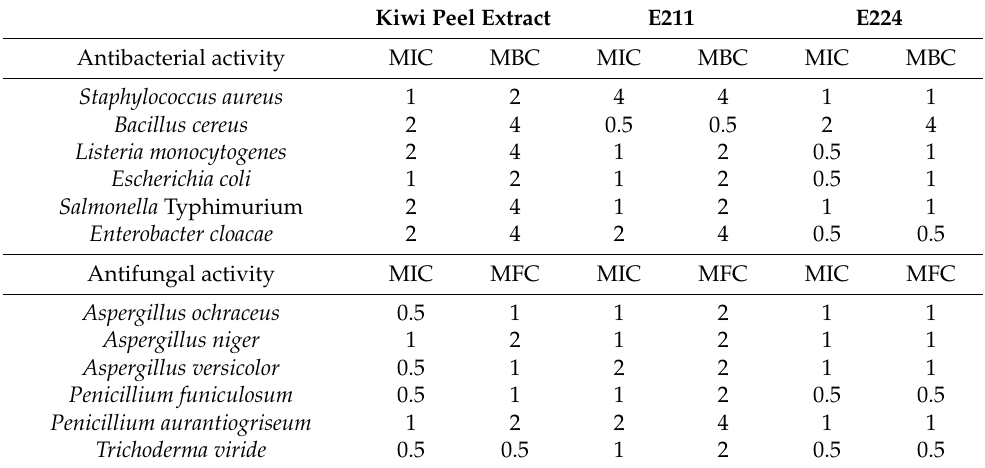
Table 4. Antimicrobial activity of the kiwi peel extract obtained under optimized UAE